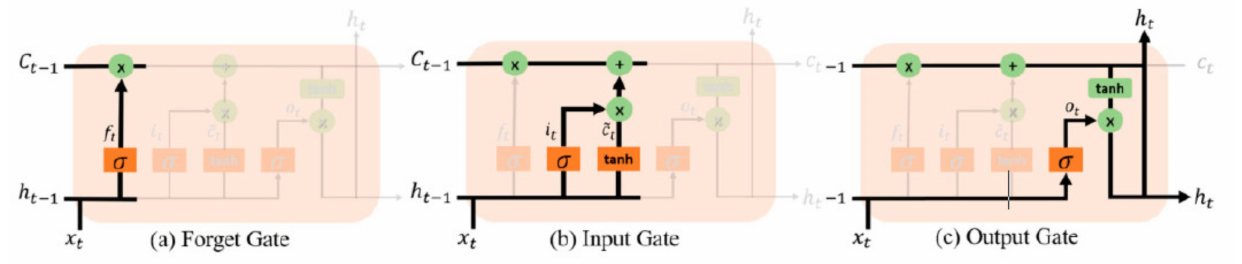
Figure 4. Long short-term memory (LSTM) architecture